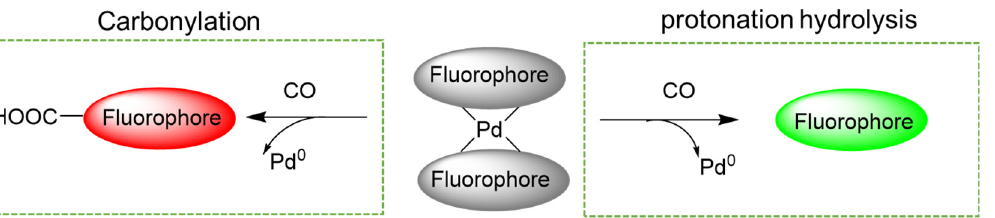
Figure 2. The mechanism diagram of carbonylation or protonation hydrolysis of cyclic palladium metal complexes.